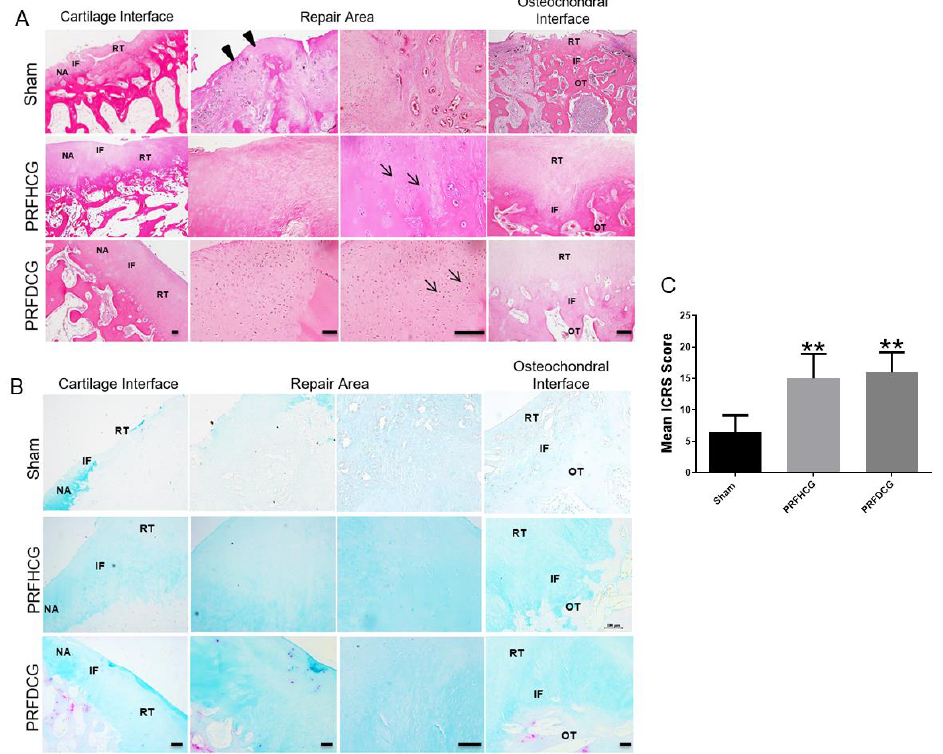
Figure 5. ( A ) Hematoxylin and eosin (H&E) staining of histological sections of representative defects from the control group (upper panel) and the groups treated with platelet-rich fibrin and either hand-diced cartilage grafts (PRFHCG group, middle panel) or device-diced grafts (PRFDCG group, lower panel). In untreated controls, the defect was partially filled with fibrous-like repair tissue (arrowheads). In the treatment groups, the cartilage surfaces were smooth and continuous, indicating satisfactory interface integration between the implanted cartilage grafts and native cartilage. The defects were covered with implanted cartilage grafts, resulting in newly grown repair tissues with mature lacuna structures (arrows). Scale bars: 100 μm. ( B ) Alcian blue staining of histological sections of representative defects of the three groups. Scale bars: 100 μm. NA, native area; IF, interface; RT, repaired tissue; and OT, subchondral bone. ( C ) Mean International Cartilage Repair Society scores evaluating repair tissues in the control, PRFHCG, and PRFDCG groups at 6 months. The bars indicate the mean ± standard deviation ( n = 4) for each group. ** p < 0.01.